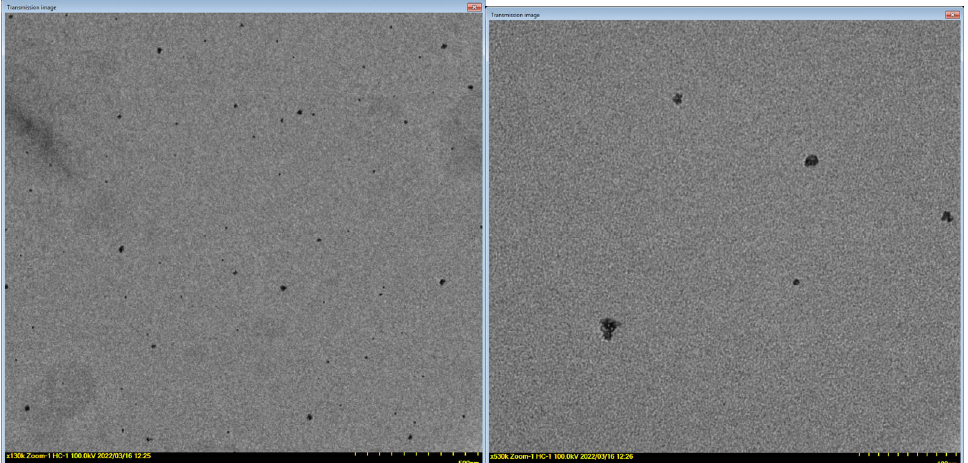
Figure 10. TEM micrographs of PEBSA–Eryt